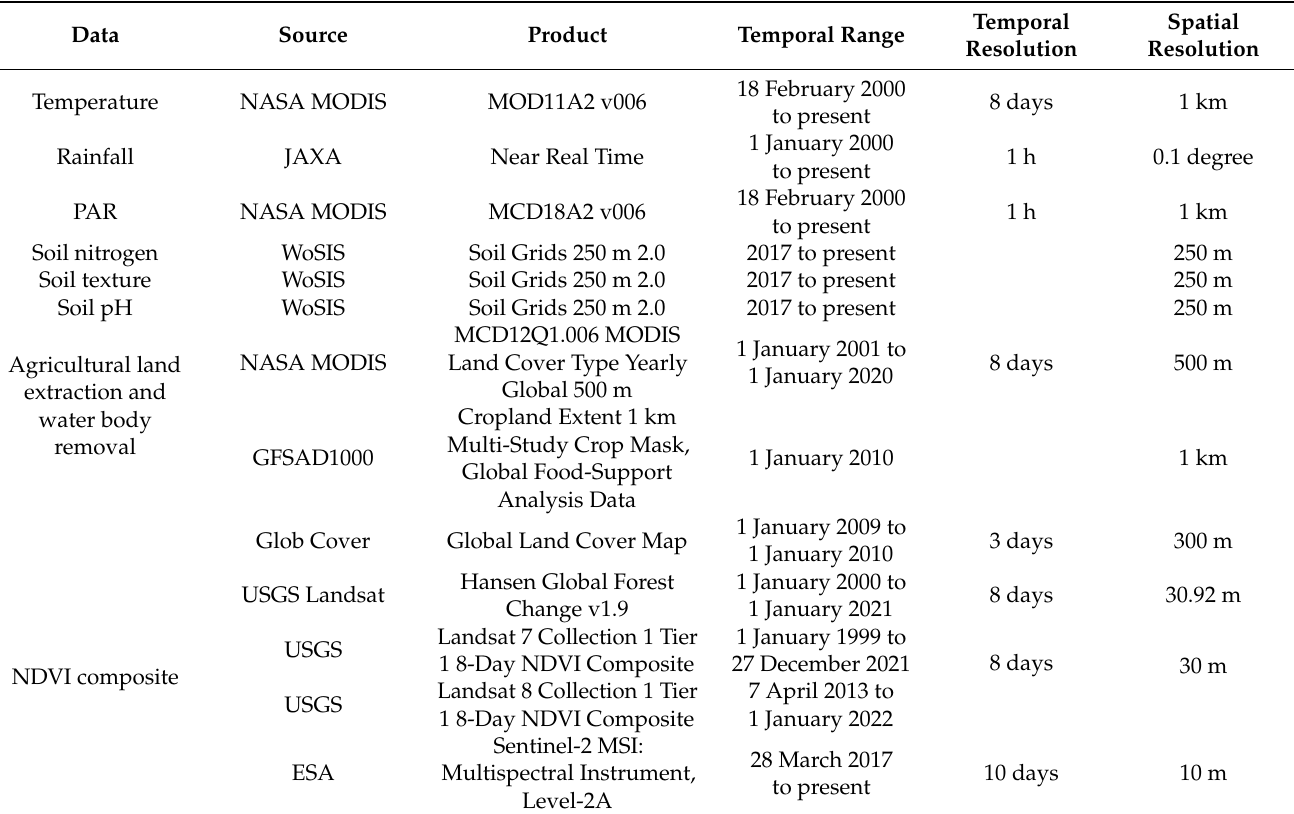
Table 1. Details of input